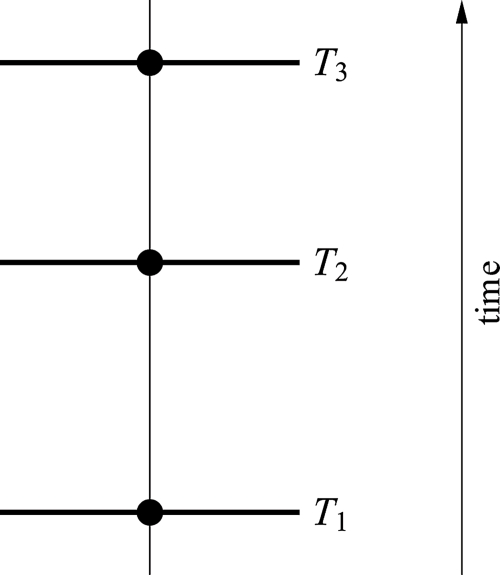
When the tree consists of only one lineage from which samples are taken at times T1, T2 and T3, then clearly the distance d1,3 is always larger than d1,2 and d2,3. Consequently, E1,3 > max{E1,2, E2,3}.